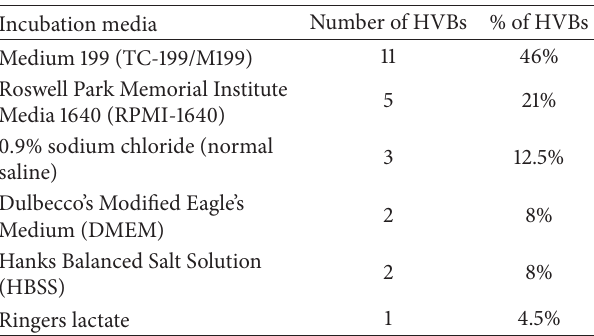
Table 5: Types of incubation media used for decontamination of